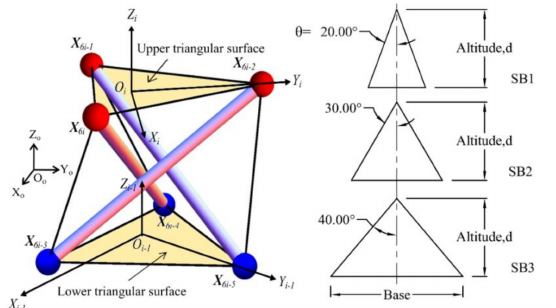
Figure 5. Definition for the typical triangular cell and triangular surfaces for spine biotensegrity